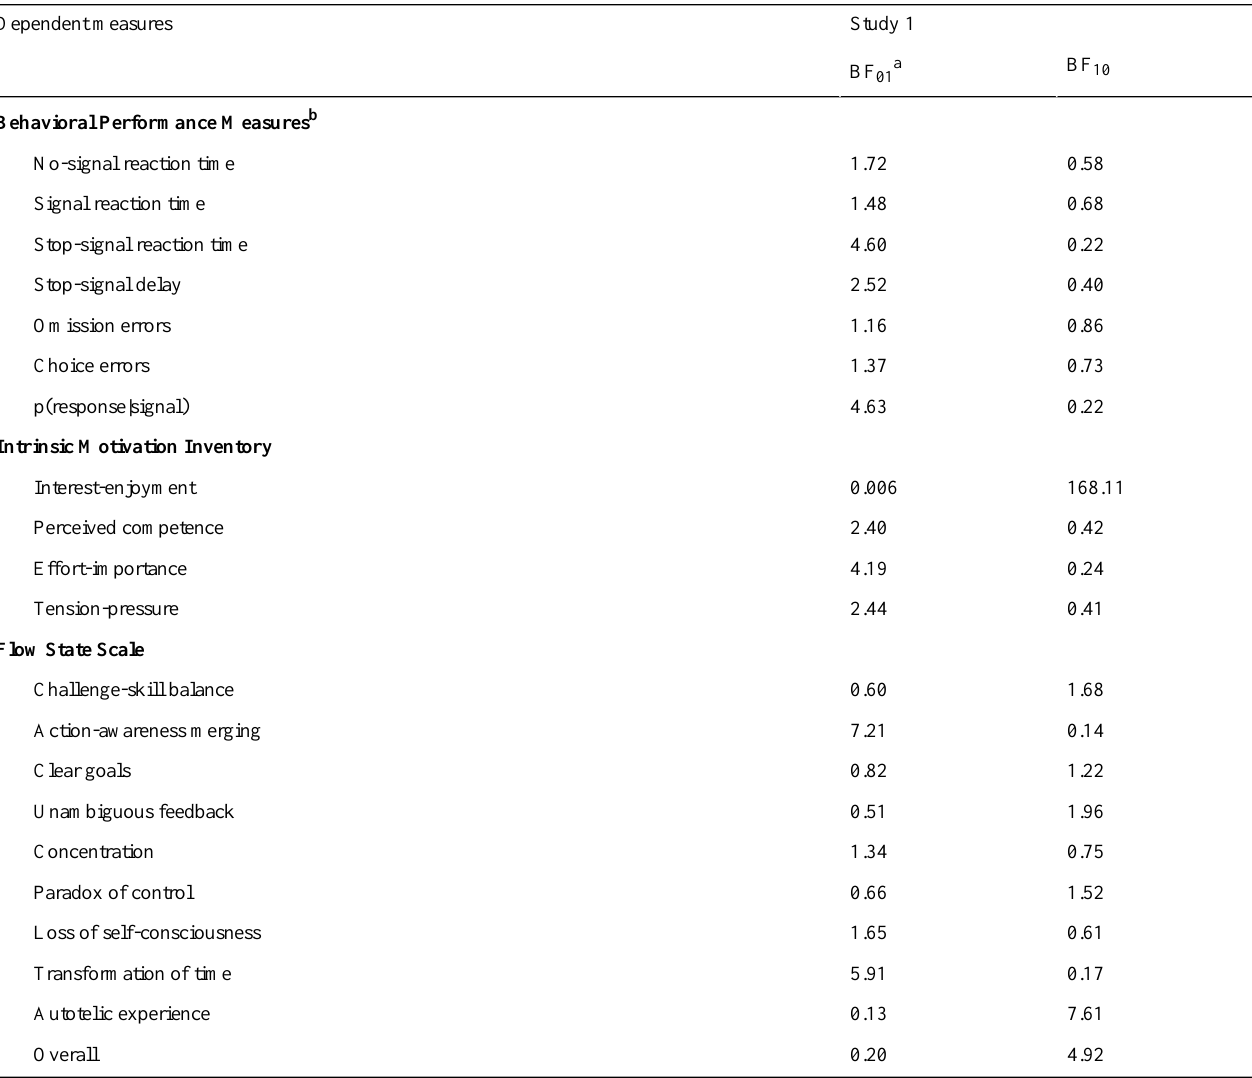
Table 5. The Bayes factor table for study 1 shown by BF01 and BF10.